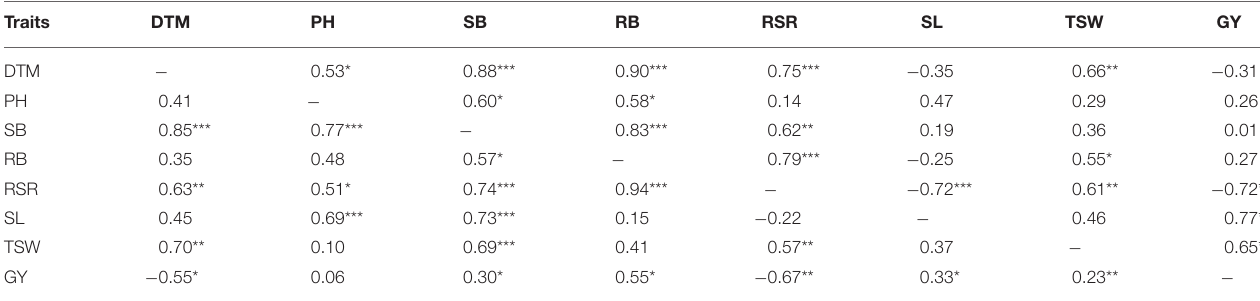
TABLE 6 | Pair-wise correlation coefficients among agronomic traits measured in three EMS-treated and control populations of wheat evaluated under water-stressed (lower diagonal) and non-stressed (upper diagonal) conditions during the M 3 and M 4 generations. Traits DTM PH